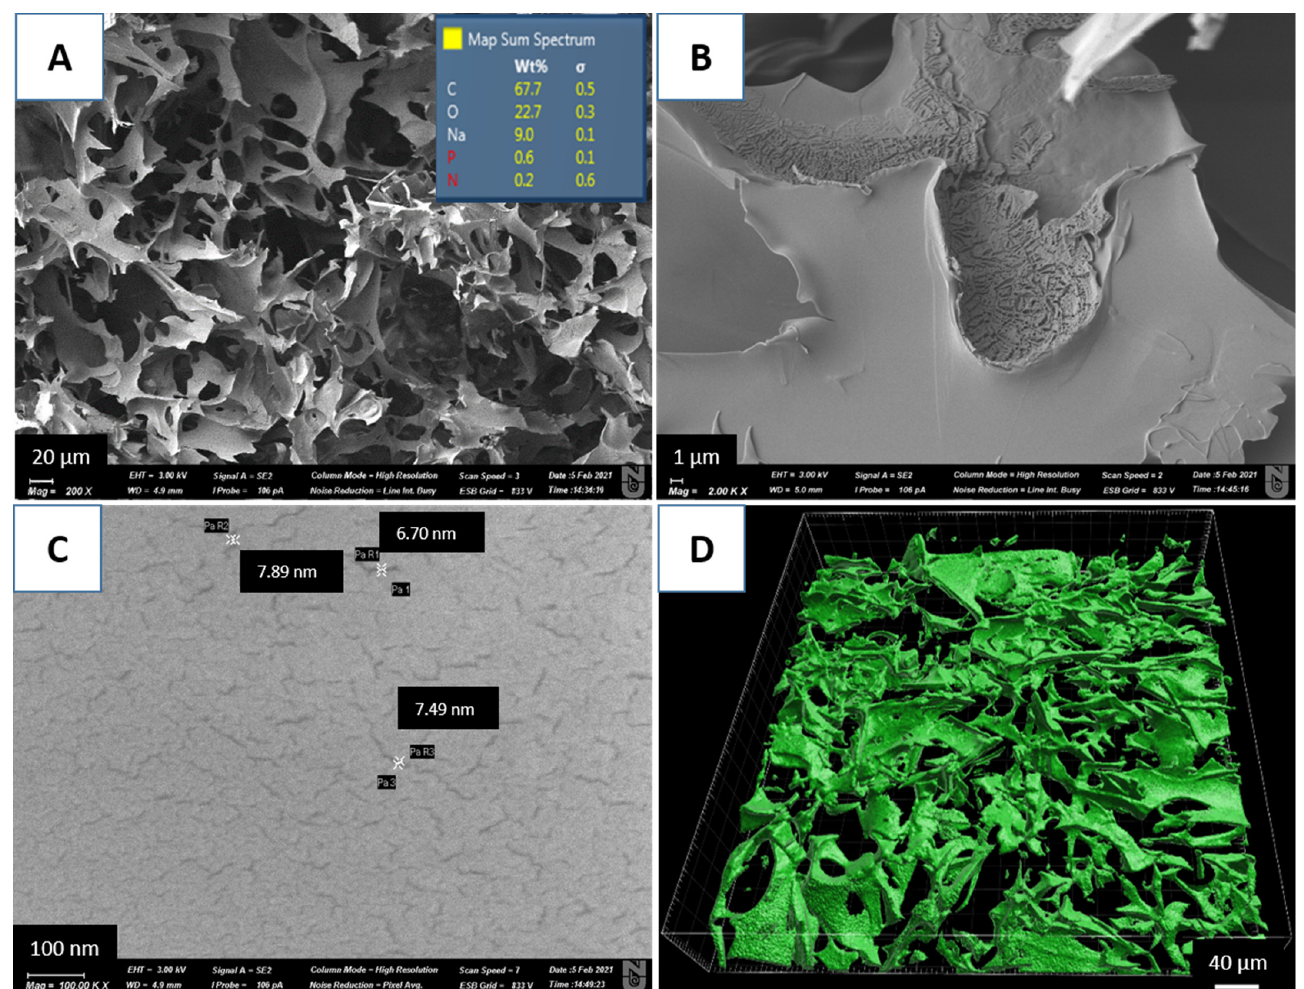
Figure 1. SEM/EDX images of AAC cryogel at magnifications of ( A ) 200×, ( B ) 2000×, and ( C ) 10,000× and ( D ) a confocal microscopy image at 20× magnification.